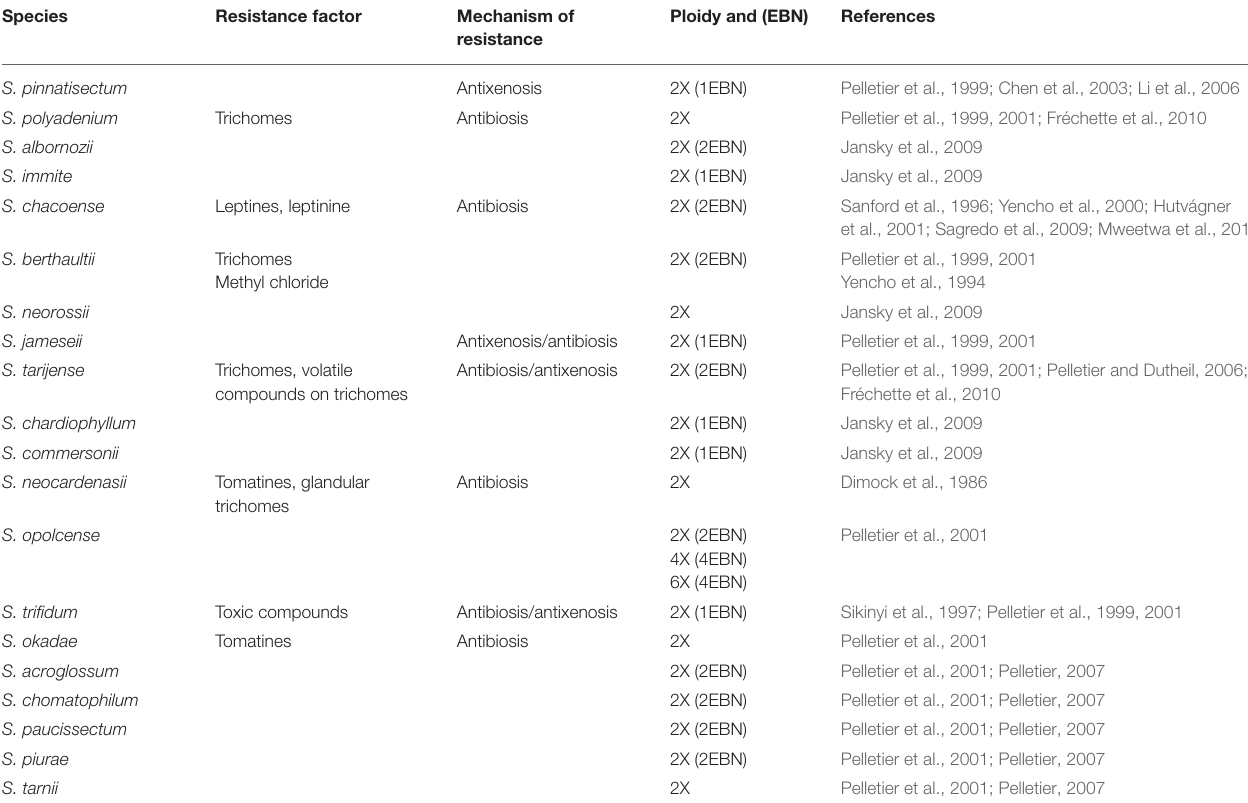
TABLE 3 | Wild Solanum species of potato exhibiting resistance to Leptinotarsa decemlineata .